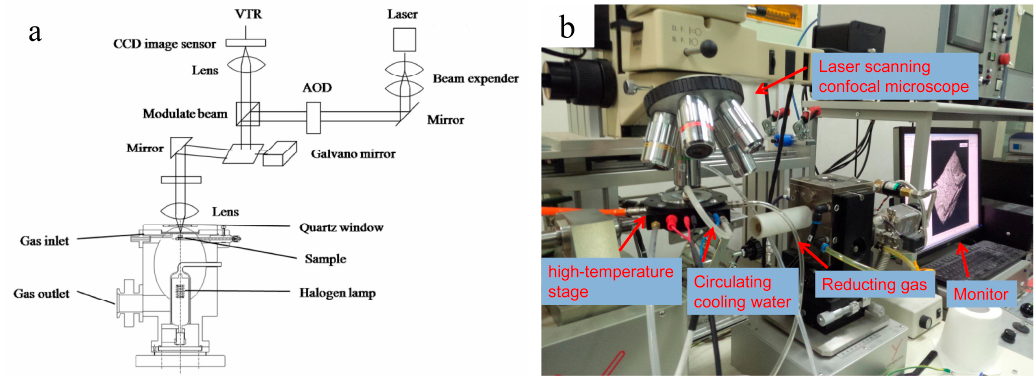
Figure 3. Sketch and real product maps of the high-temperature laser scanning confocal microscope ( a ): Sketch map, ( b ): Real product map).